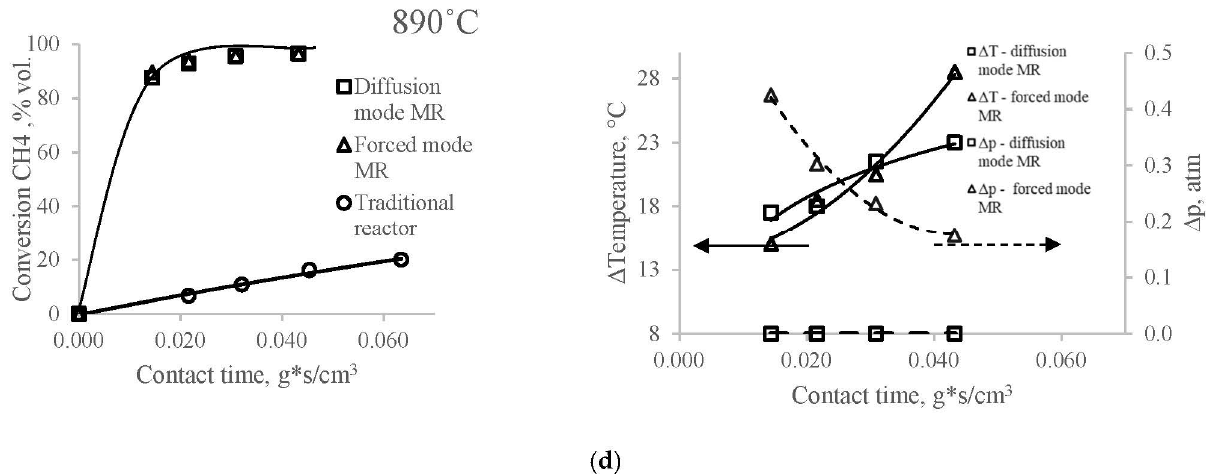
Figure 2. Dependence of methane conversion, temperature difference and pressure drop in reactors with membrane catalyst in contactor mode with forced and diffusion transport of reactants and with traditional catalyst on contact time at temperatures 820, 850, 870 и 890 ◦ C ( a – d , respectively). DRM: CH 4 :CO 2 = 1:1. MC: weight of catalytically active component—0.153 g (Mo 2 C); TC: weight of catalytically active component—0.261 g (Mo 2 C).